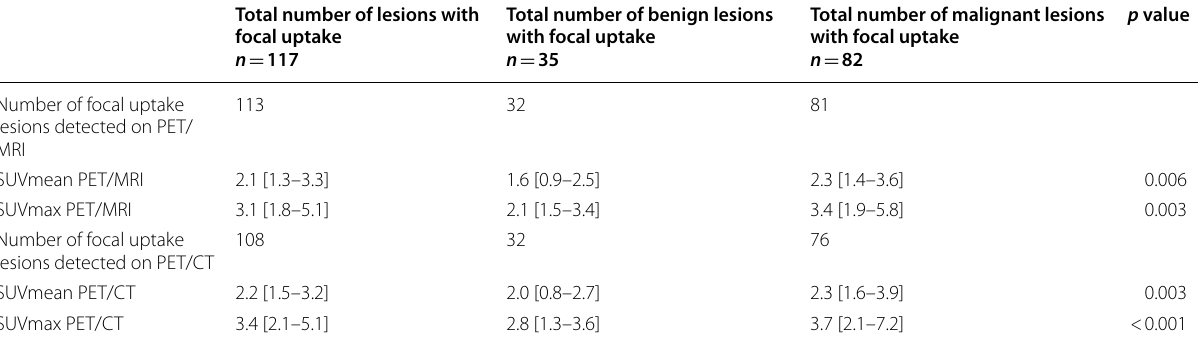
Median values and interquartile intervals are presented. Among the 117 lesions with focal uptake, 104 were detected by the two readers on both modalities, 9 only on PET/MRI and 4 only on PET/CT. Four focal uptake lesions (3 benign and 1 malignant) were missed on PET/MRI, and 9 focal uptake lesions (3 benign and 6 malignant) were missed on